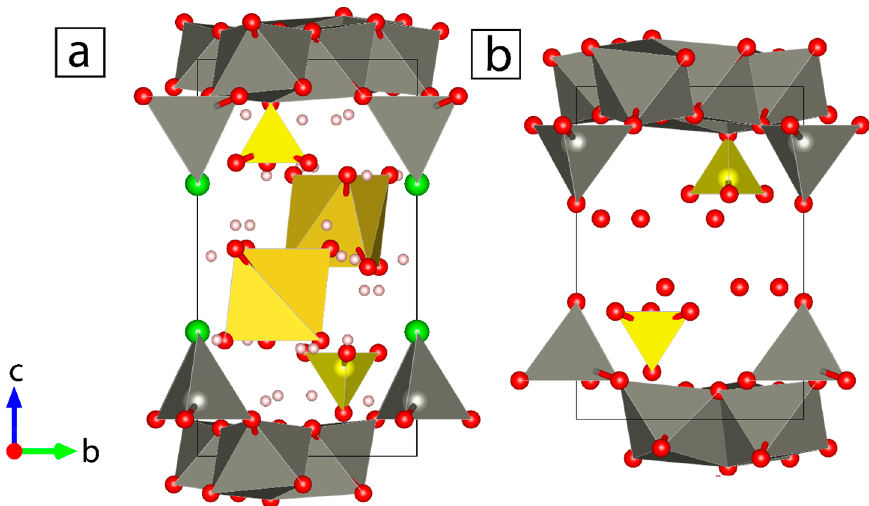
Figure 10. Structure of ( a ) gordaite (after [30]) and ( b ) namuwite (after [31]) along the c-axis (red atoms = O, green atoms = Cl, center of yellow tetrahedrons = S, center of yellow octahedrons = Na; crystal structures were created with the software VESTA).